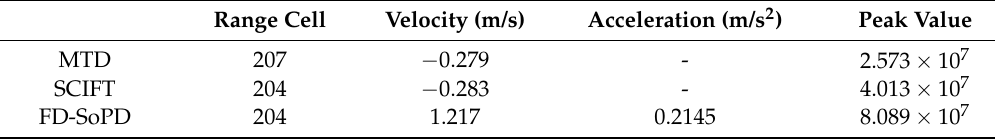
Table 5. Comparisons of experimental parameter estimation